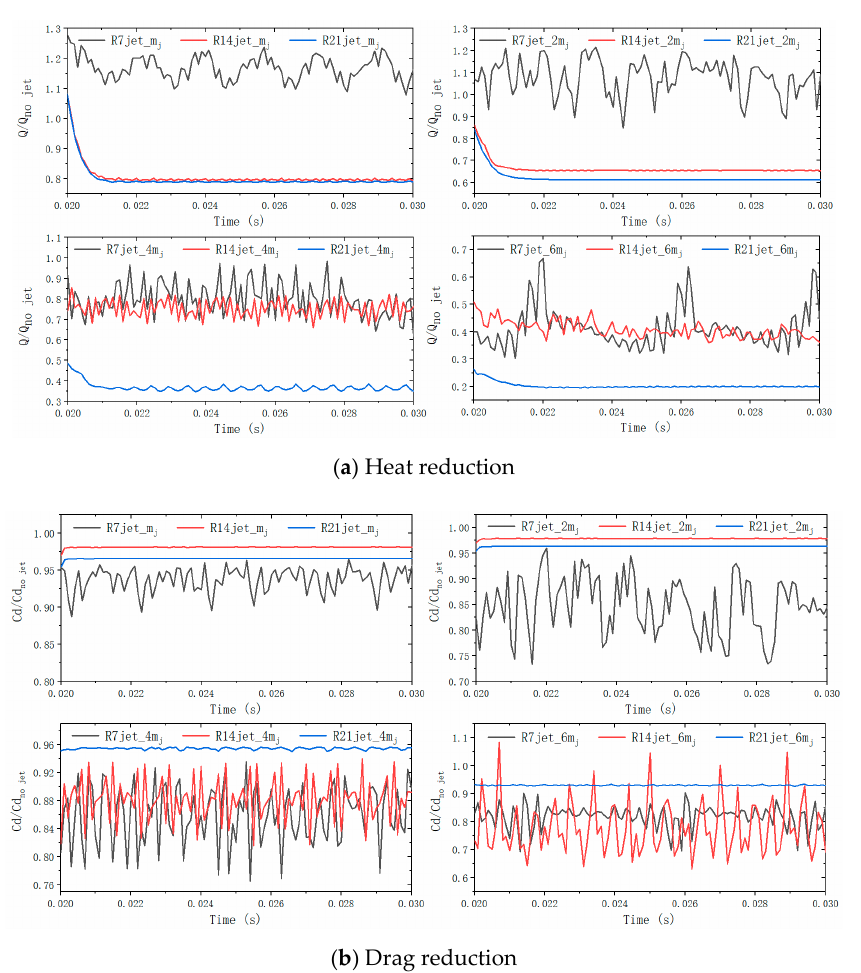
Figure 13. Heat and drag reductions of R7, R14, and R21 jets with the m j –2 m j flow